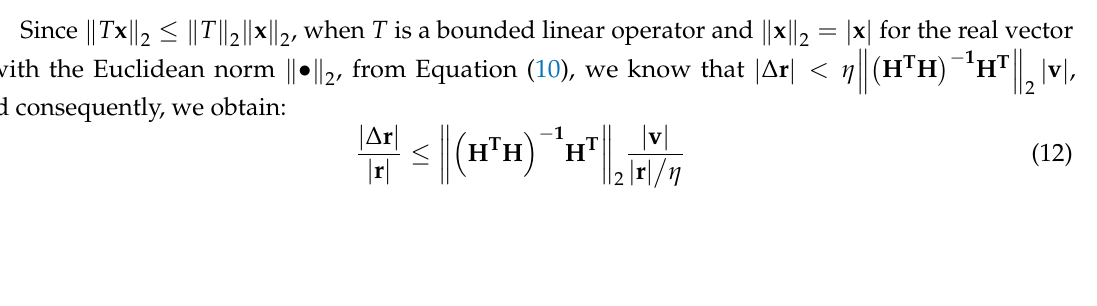
Figure 2. Geometric relations between the orientation error θ and the vectors r , r (cid:48) , and ∆ r Fig. 2. Geometric relations between the orientation error 𝜽 and the vectors r , r ´ , and Δ r